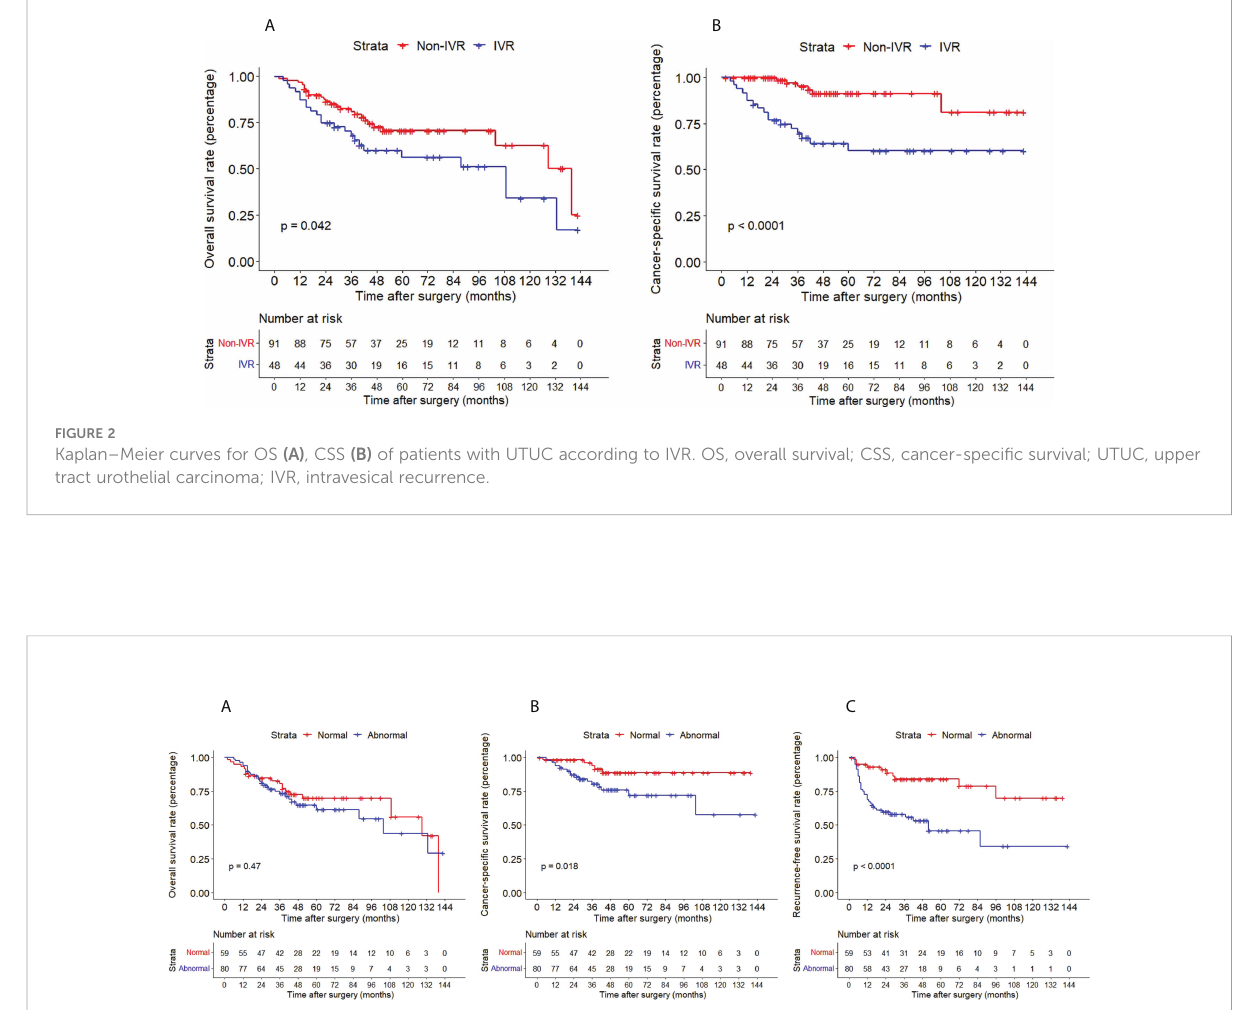
FIGURE 3 Kaplan – Meier curves for OS (A) , CSS (B) and RFS (C) of patients with UTUC according to urine cytology. OS, overall survival; CSS, cancer- speci fi c survival; UTUC, upper tract urothelial carcinoma; IVR, intravesical